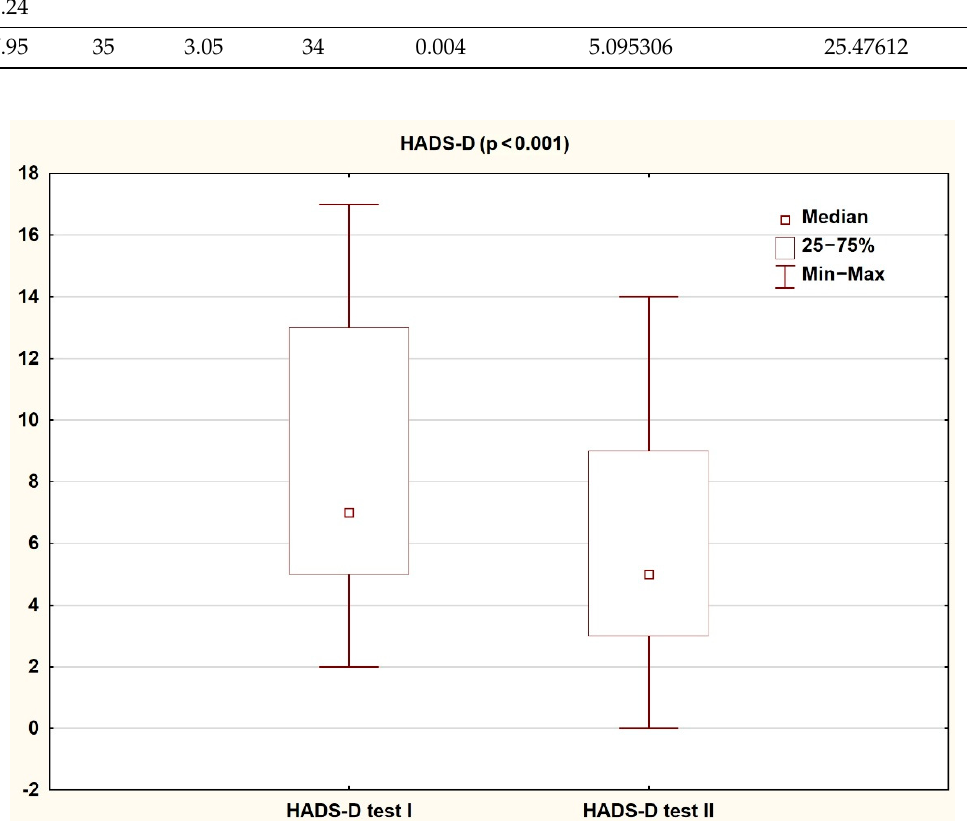
Figure 2. Patient results in the HADS-D subscale during the first and second study (Wilcoxon test).